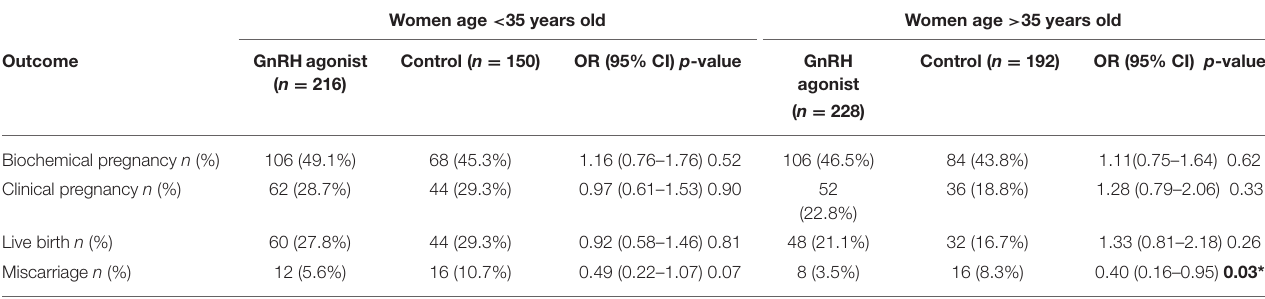
TABLE 4 | Pregnancy outcomes between GnRH agonist and control group following women age.